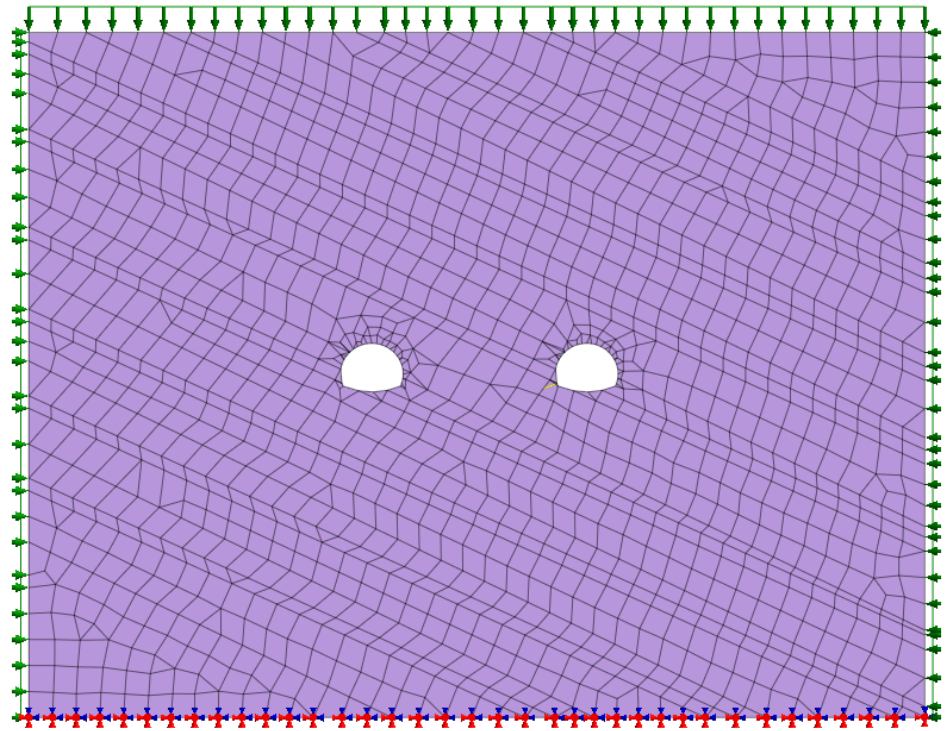
Figure 17. Numerical simulation model of the tunnel. Table 8. The orthogonal test design plan and calculation results for Point 4.